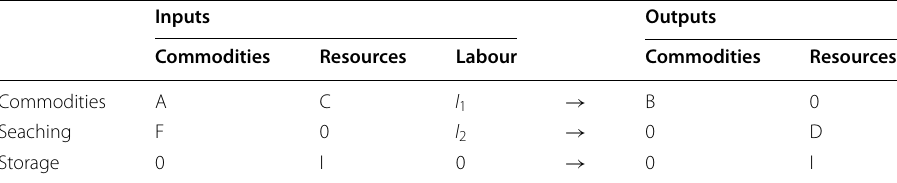
Table 1 Input–output